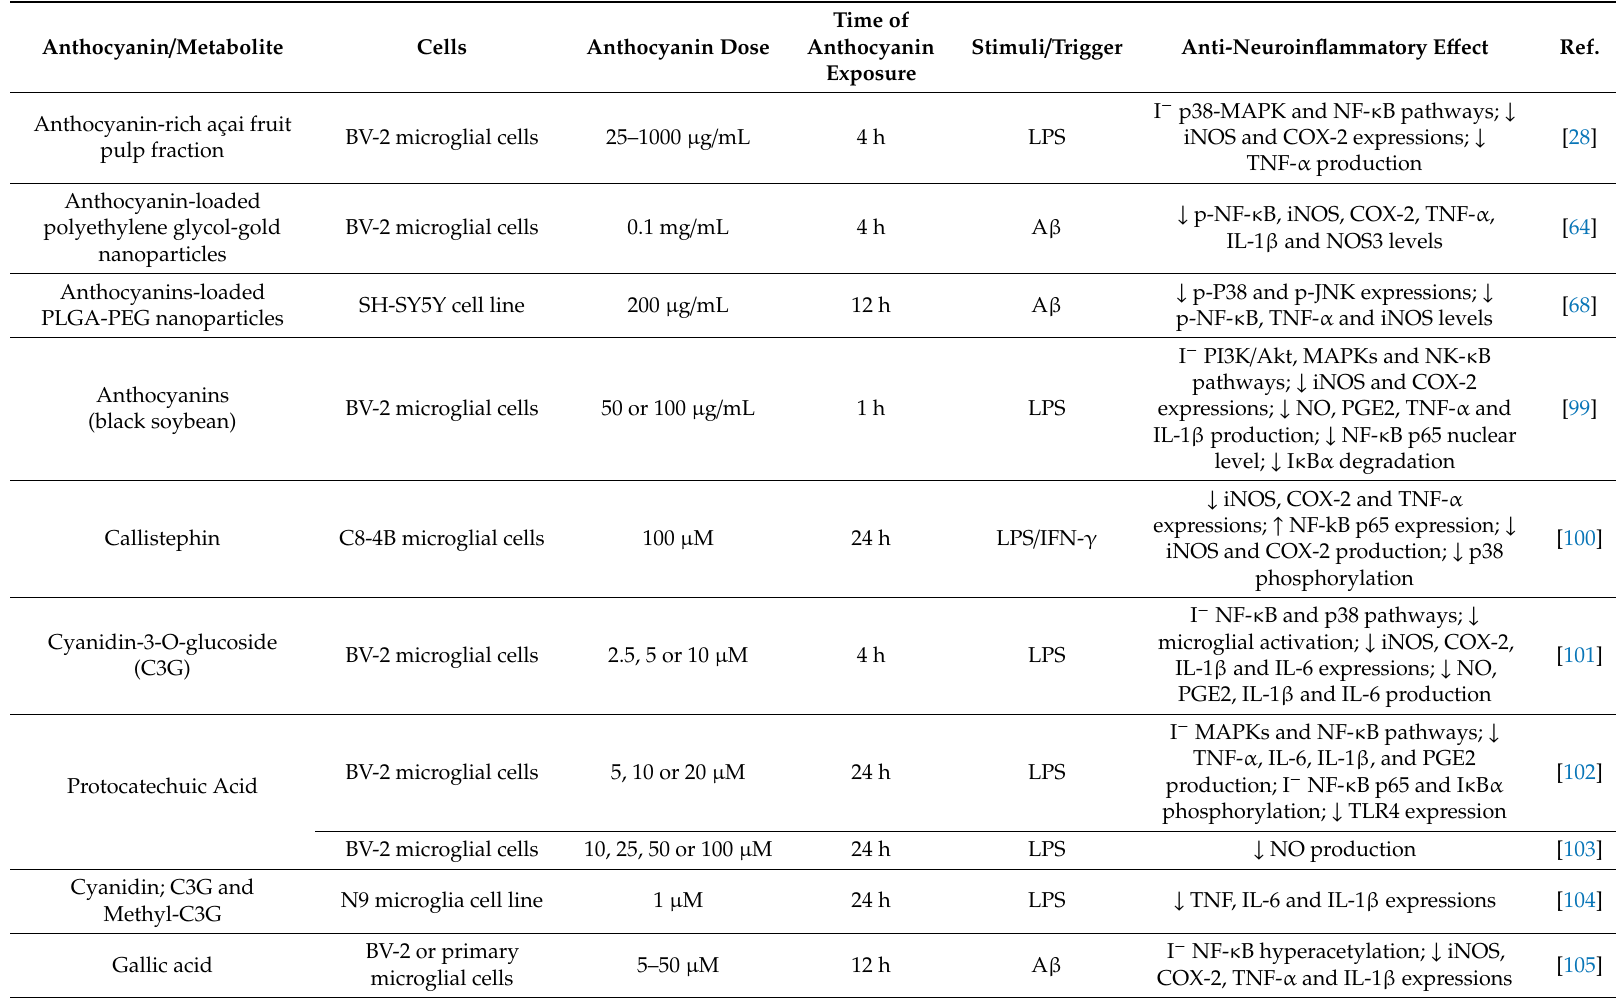
Table 1. Summary of the in vitro studies showing the anti-neuroinflammatory role of anthocyanins and their metabolites. I − = inhibition; ↓ = reduction; ↑ = increase. Time of Anthocyanin / Metabolite Cells Anthocyanin Dose Anthocyanin